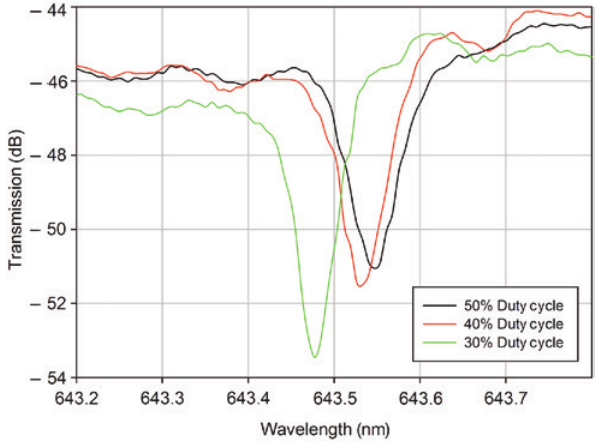
Figure 26: First-order WBGs fabricated in the visible spectrum using a 1 kHz laser and the modulated burst